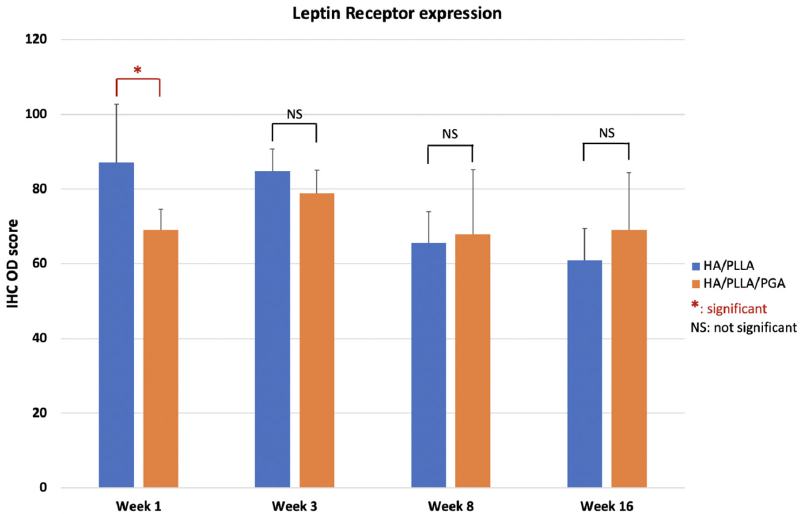
Figure 14. IHC OD score of LepR in the u-HA/PLLA and u-HA/PLLA/PGA groups. * p < 0.05. 3.4.3. OCN The expression patterns of OCN were similar between groups. At weeks 1 and 3, low expression of OCN in the area near parent bone showed that the newly formed bone was immature. At weeks 8 and 16, the area of the defect in contact with parent bone had higher OCN expression. This indicated that the new bone had gradually matured (Figure 15).